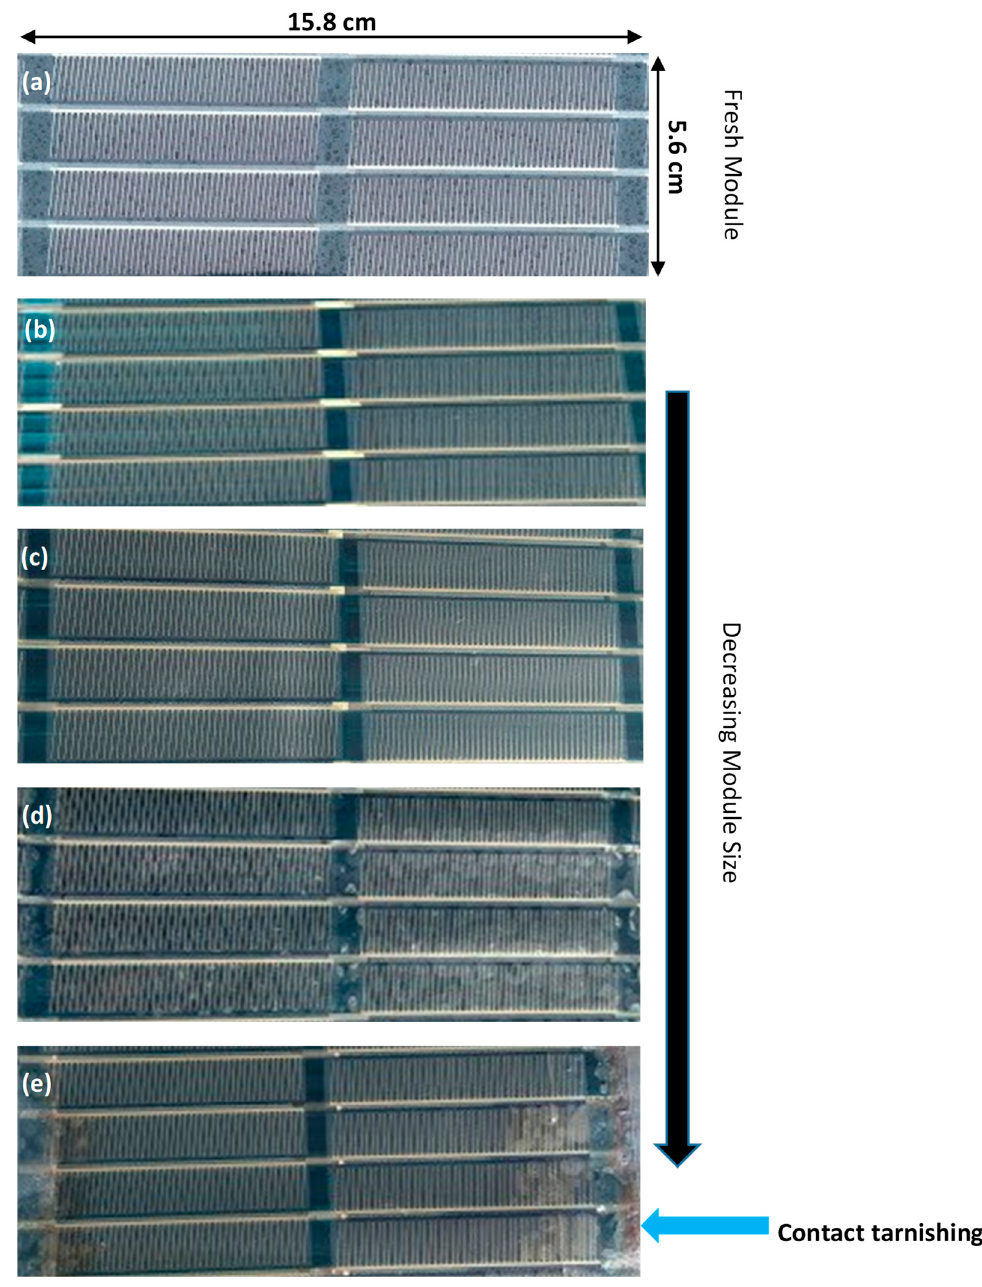
Figure 4. ( a ) Active material at beginning of test period. ( b ) 5904 cm 2 module, ( c ) 2928 cm 2 module, ( d ) 720 cm 2 module and ( e ) 360 cm 2 modules after test period. Images taken at centre of each